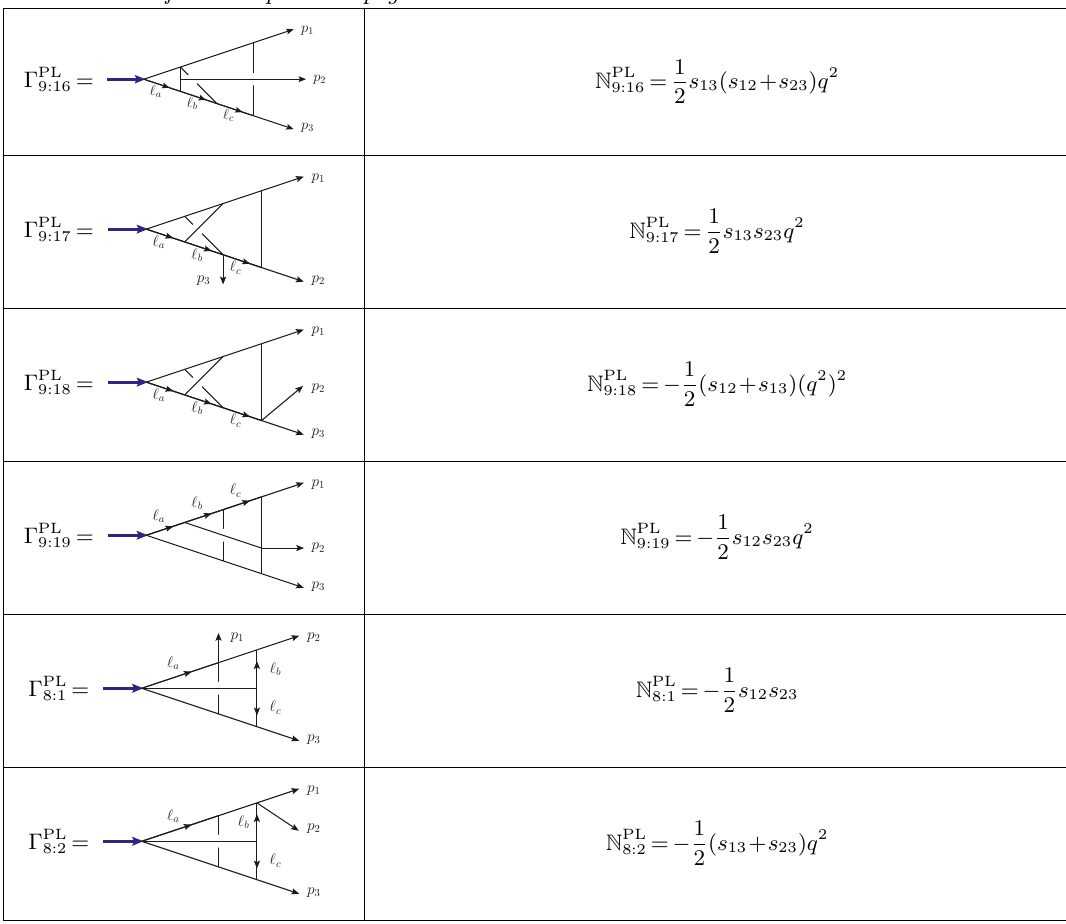
Table 3. N c -leading tr( φ 2 ) form factor results in